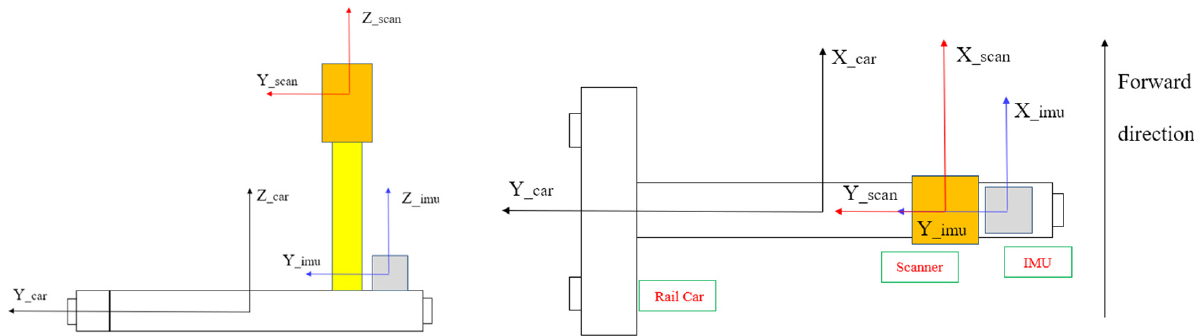
Figure 4. Schematic diagram of the coordinates of the main sensors of TMLS.